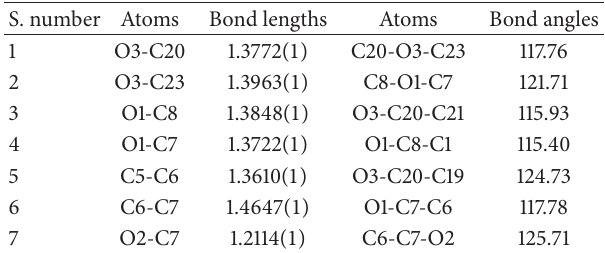
Table 1: Bond lengths and bond angles of ( vi-e ) have been